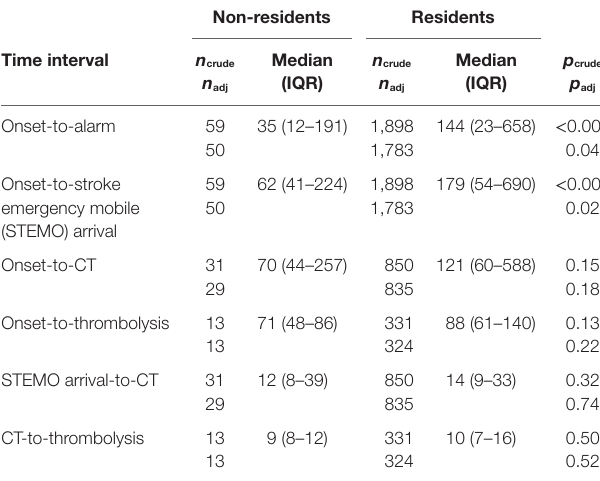
TaBle 2 | Distribution of time intervals for non-resident and resident stroke patients.